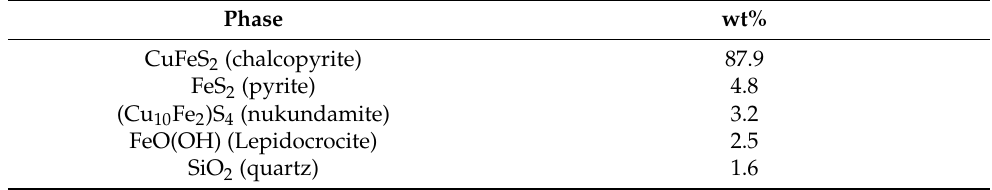
Table 3. Quantitative crystalline phase analysis by XRD of the chalcopyrite concentrate after